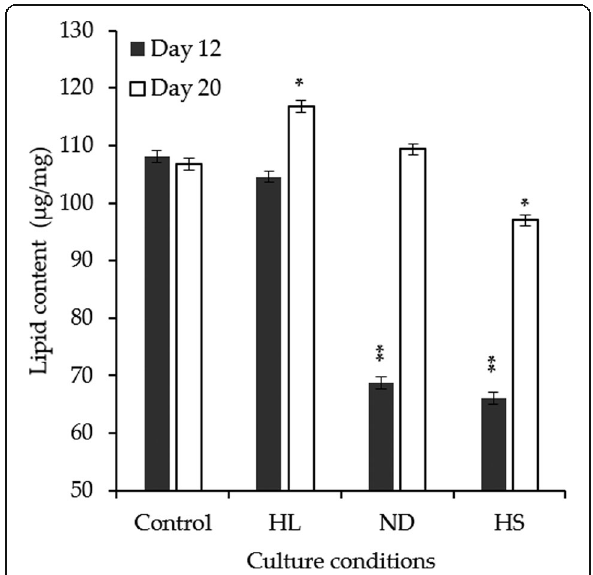
Fig. 3 Lipid contents of D. salina Y6 under the tested abiotic-stress conditions. HL, high-light conditions; ND, nitrogen-depleted conditions; HS, high-salt conditions. ** p < 0.01, * p < 0.05. The values represent mean ± S.D. ( n =